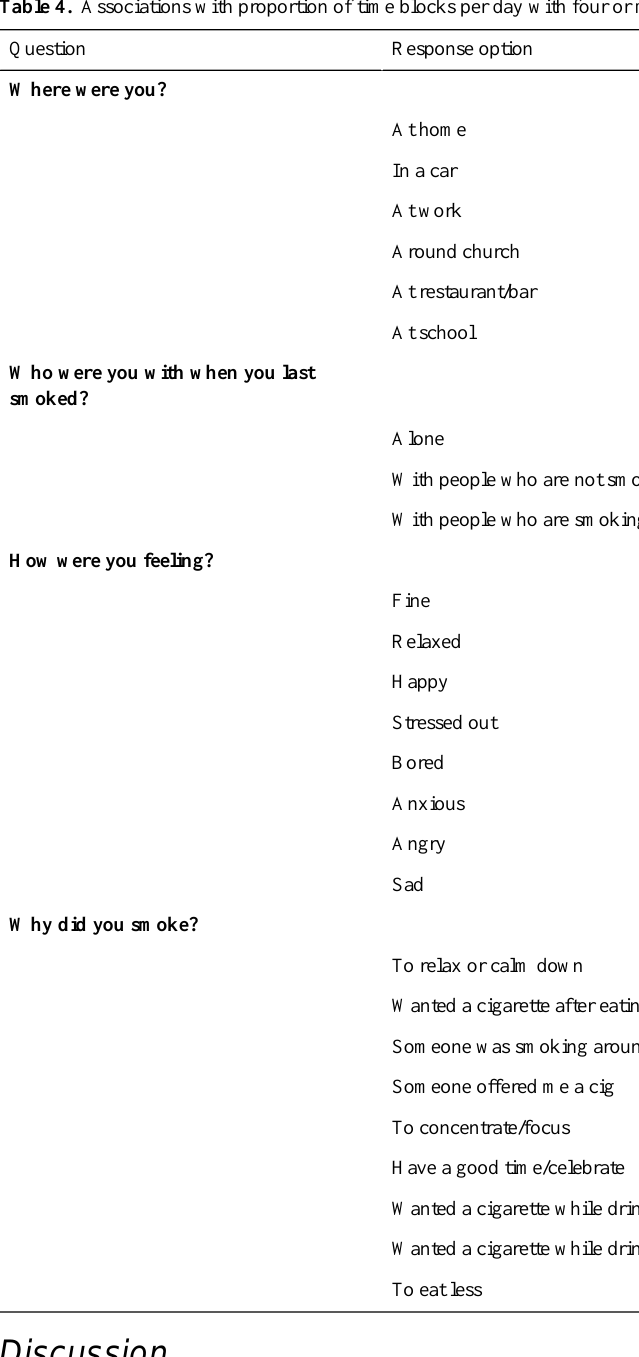
Table 4. Associations with proportion of time blocks per day with four or more cigarettes. Where were